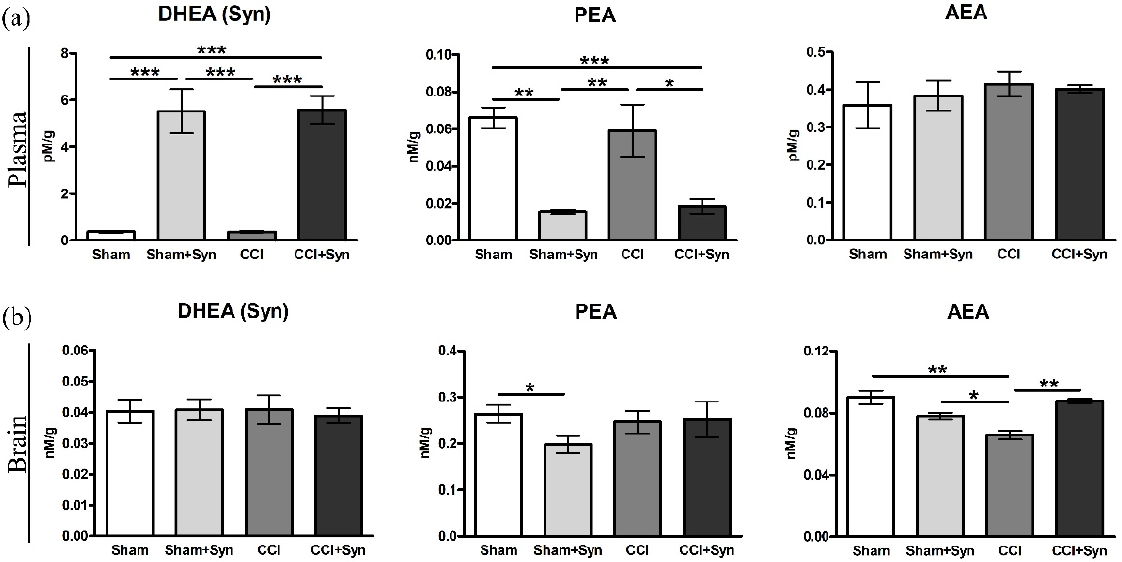
Figure 8. The results of the rat ( a ) brain and ( b ) plasma LC-MS N-acylethanolamines analysis after CCI and synaptamide treatment. Data are presented as mean ± SEM, n = 5/group, * p < 0.05, ** p < 0.01, and *** p < 0.001 (one-way ANOVA, post-test Tukey).